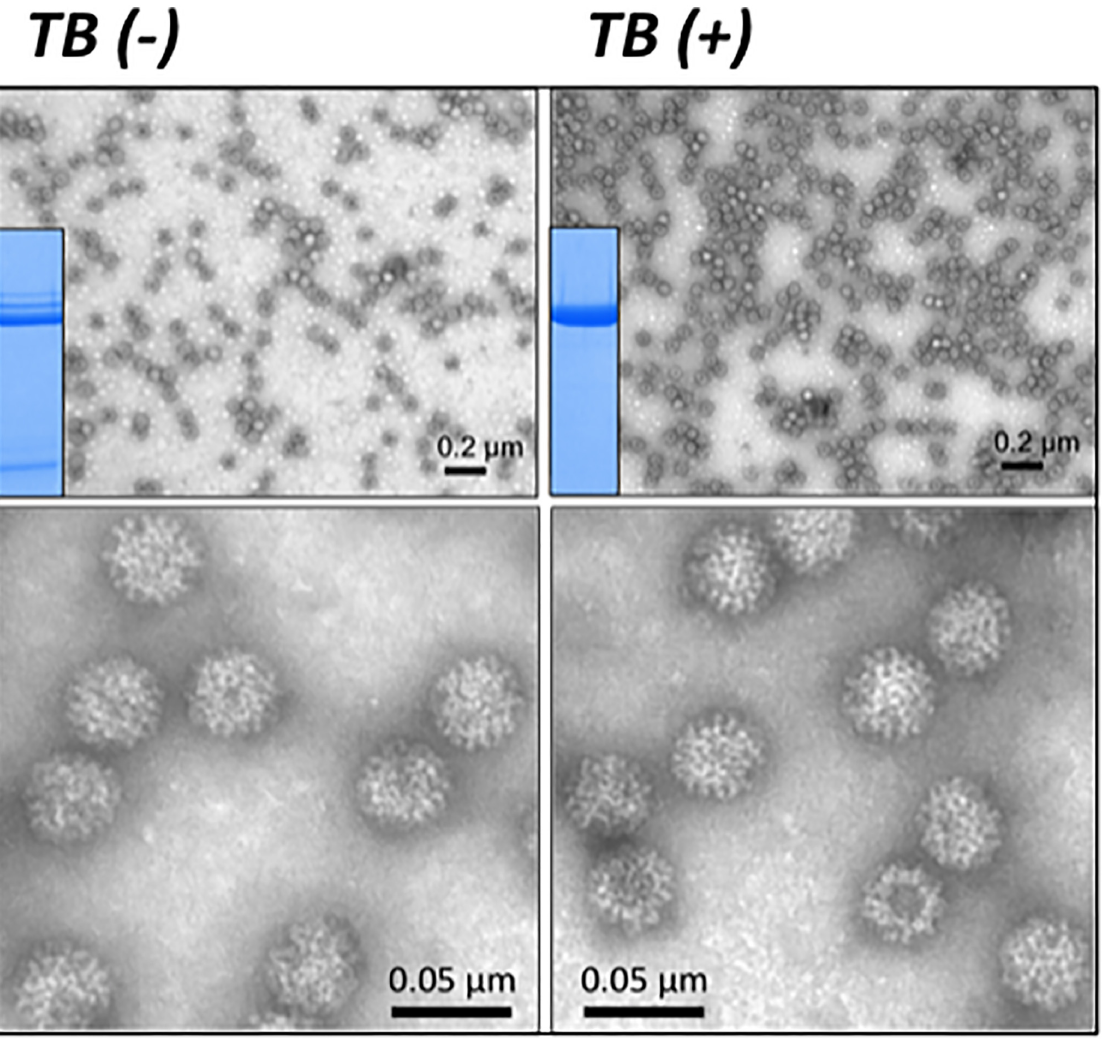
Fig 5. VLPs formed after infection of Sf9 cells with a conventional TB(-) or a TB (+) baculovirus expressing the VP1 and VP2 encoding genes from RHDV. Extracts from infected cells at the optimal production times with each baculovirus were processed for VLP purification. The protein patterns of purified VLPs obtained with each baculovirus are shown in the inserts (Coomassie blue stained). Samples were observed by Electron microscopy using negative staining. The figure shows the VLPs at two magnifications. VLPs obtained with the two baculoviruses presented identical sizes and shapes but were more abundant when produced by the TB(+) virus. The micrographs are representative of the fields